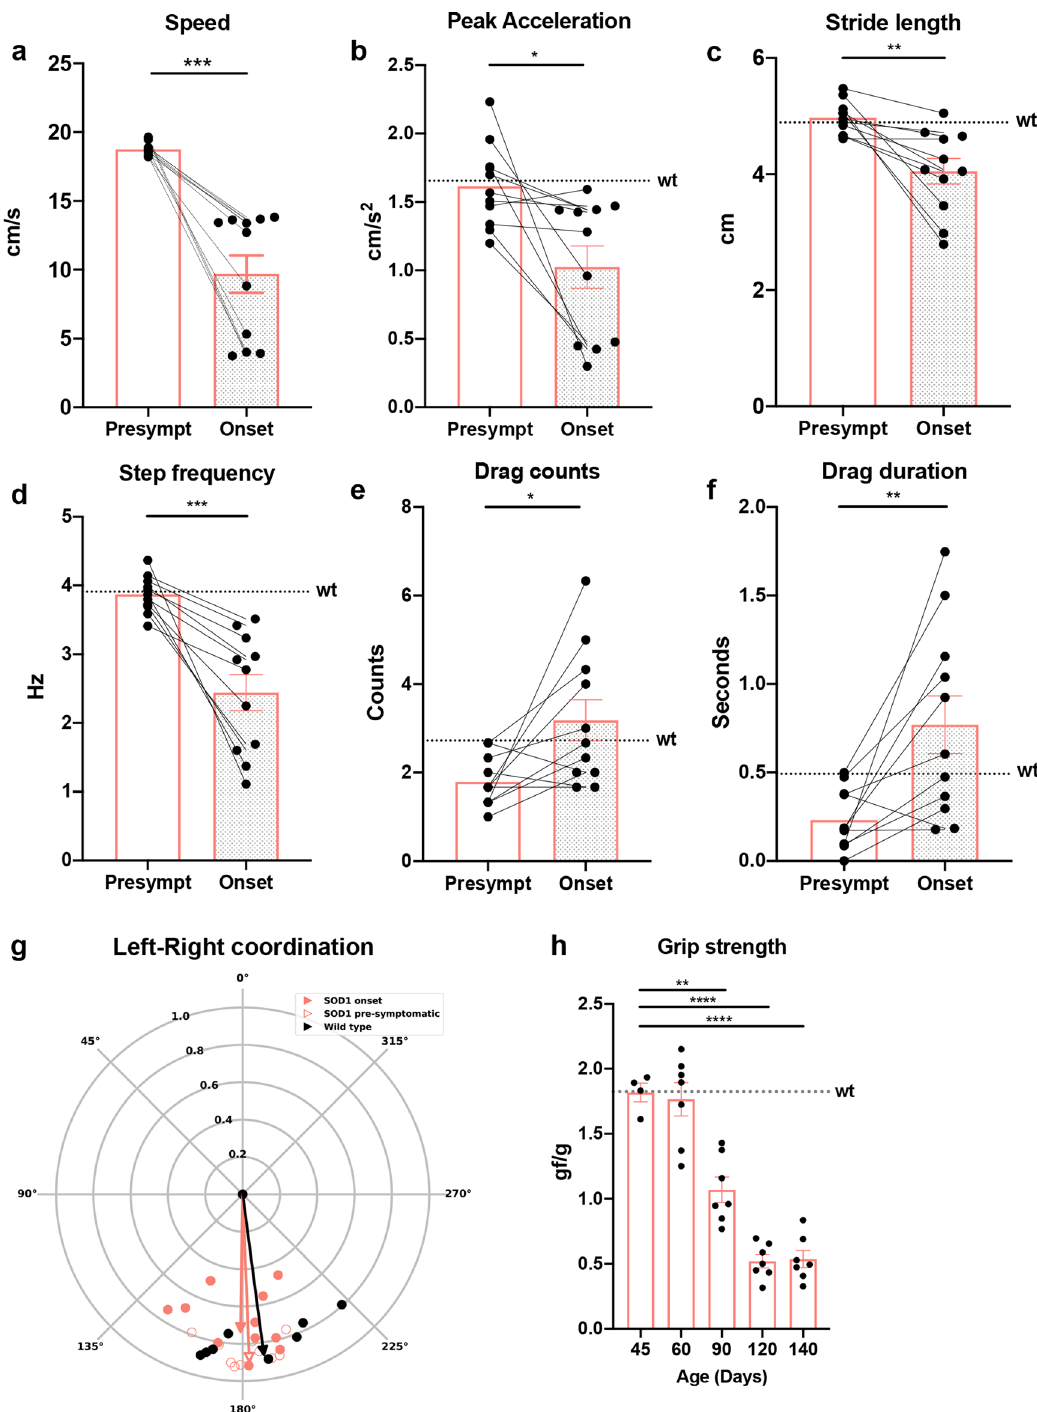
Movie 3 and 4). Seven out of twelve animals responded with a dramatic reduction in speed of locomotion (Fig. 7b), while the other fi ve showed more pronounced changes in step frequency (Fig. 7e; En1 cre ;HoxB8 FlipO ;RC::Di N = 12, controls N = 9). Interestingly, the phenotype showed by the triple transgenic mice after CNO administration recapitulated the Onset of locomotor phenotype seen in the SOD1 G93A mice. The majority of the mice showed reduced speed compared to their performance before injection and 50% of the mice maintained a speed lower than 15 cm/s (one-way ANOVA and Sidak ’ s post hoc, P = 0.0005) (Fig. 7b). Moreover, animals showed a decrease in